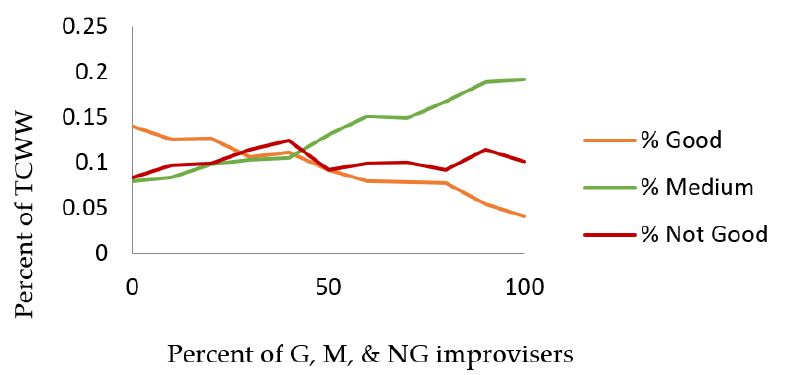
Figure 6. Percent of TCWW vs. percent of Good (G), Medium (M), and Not Good (NG) improvis- ers.